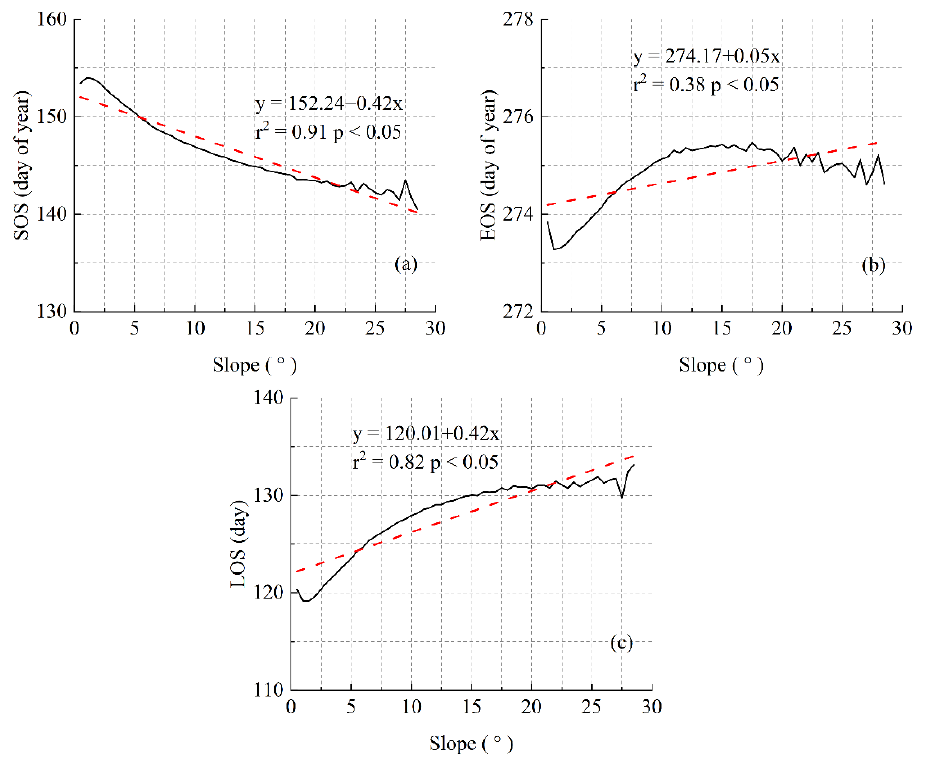
Figure 7. Relationship between the slope and vegetation phenology in the Three-River headwaters region. ( a ) Relationship between the slope and the SOS. ( b ) Relationship between the slope and the EOS. ( c ) Relationship between the slope and the